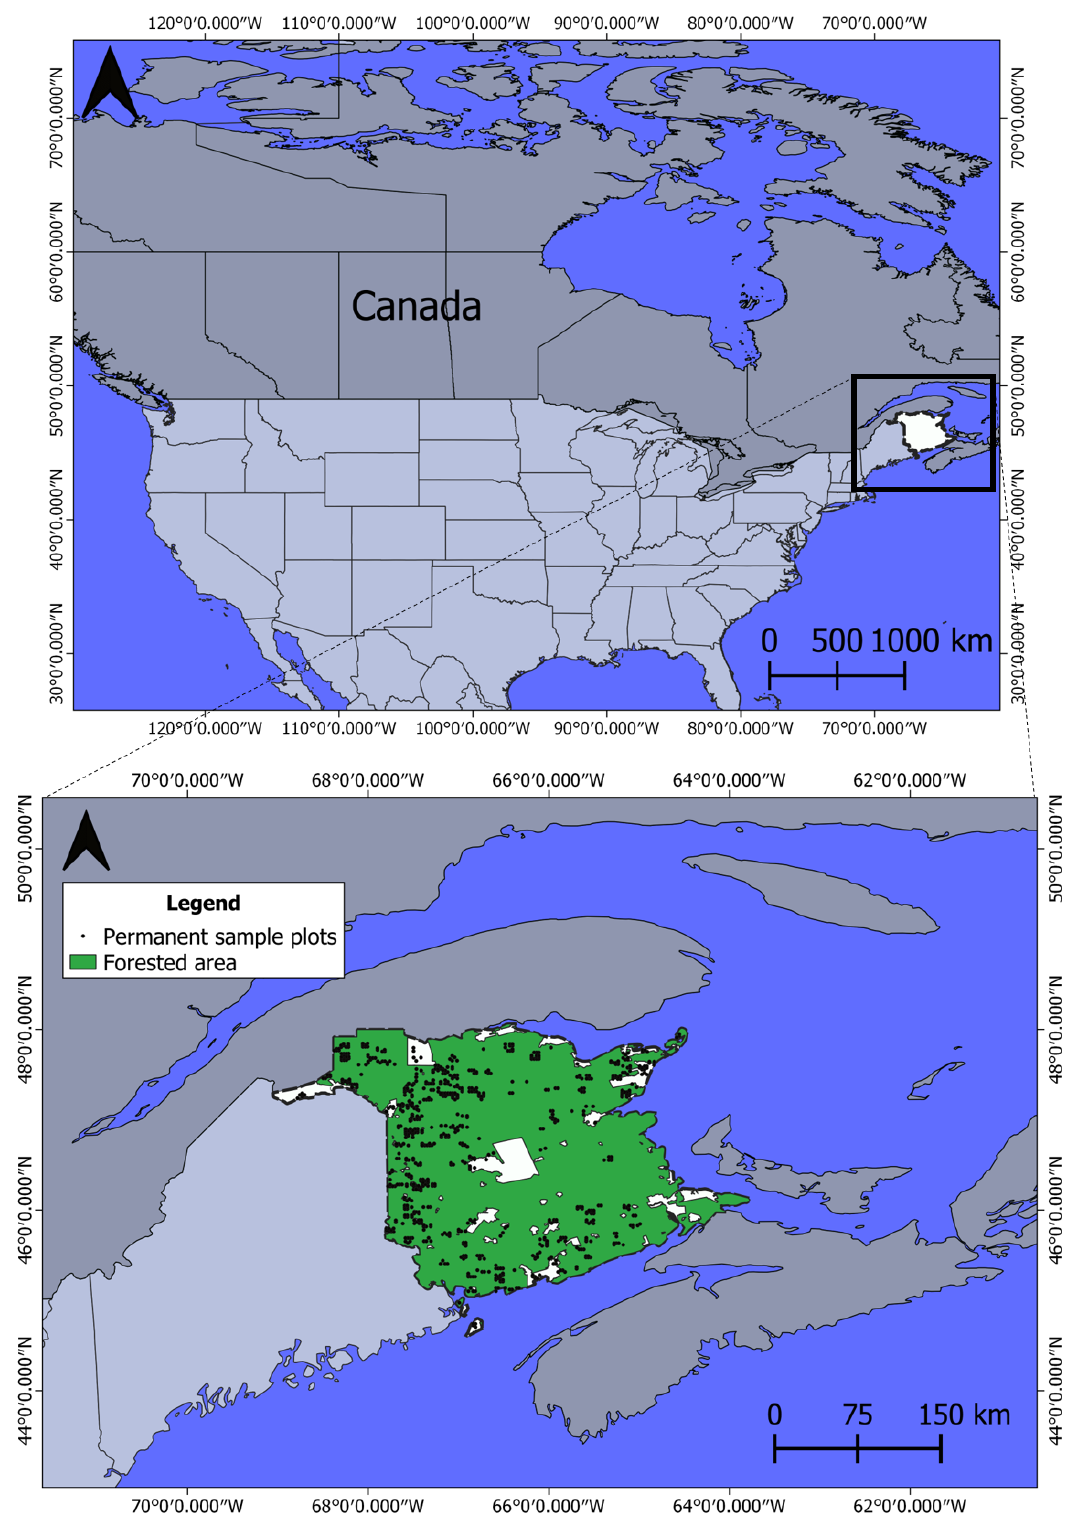
Figure 1. Location of the study area and distribution of permanent sample plots, which are scattered across the entire province of New Brunswick, Canada (CRS: WGS84).